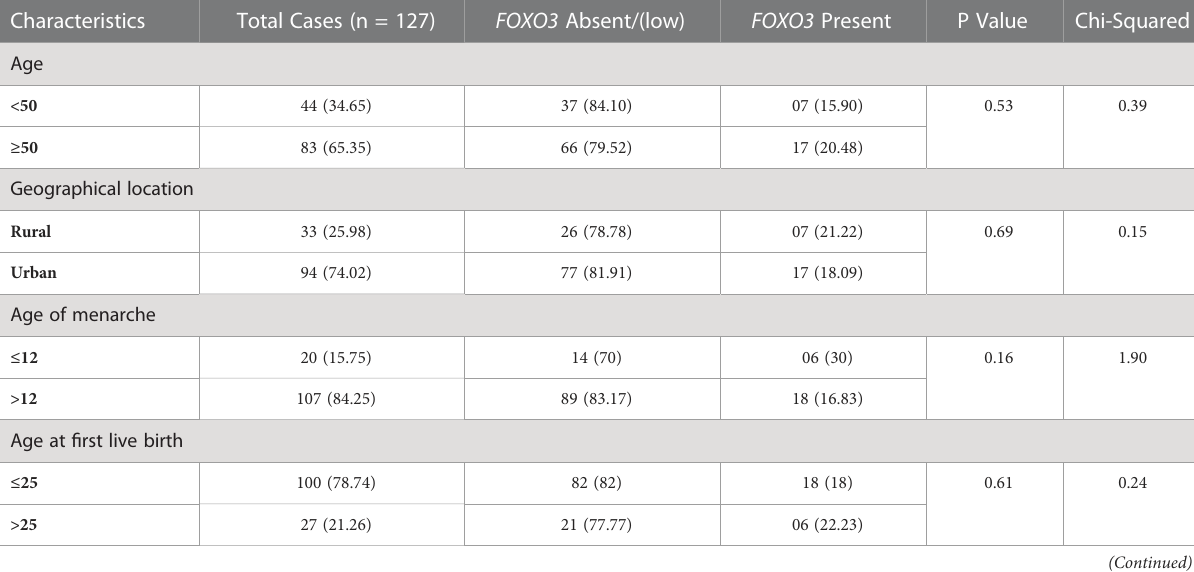
TABLE 3 Correlation of FOXO3 protein expression level with clinical parameters of breast cancer patients.